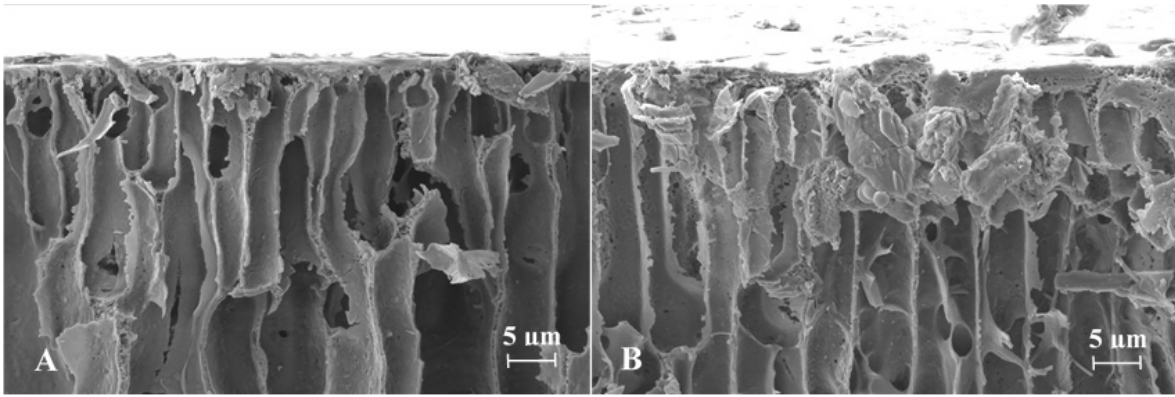
Figure 4. Scanning electron microscopy cross-section image of the sponge-like structure at the inner part of spherical in situ forming gels prepared for formulations containing 200 mg eq./g bedaquiline fumarate salt in PLGA5050A/NMP 20/80% ( w / w ) (Panel ( A ), formulation 1) and in PLGA7525A/NMP 20/80% ( w / w ) (Panel ( B ), formulation 2). For both formulations, the spherical ISGs consisted of an outer layer with finger-like pores (Figure 3), of which some formed smaller surface pores (Figure 2), and an inner sponge-like porous structure (Figure 4). The inner pores of the sponge-like structure were larger for formulation 1 compared to those of formulation 2 (Figure 4). A similar trend was observed for surface pores, which were slightly larger and lower in number for for- mulation 1 (Figure 2). Elemental mappings by SEM-EDX of the cross-section of spherical ISGs formed from formulations 1 and 2 are shown in Figures 5 and 6, respectively.